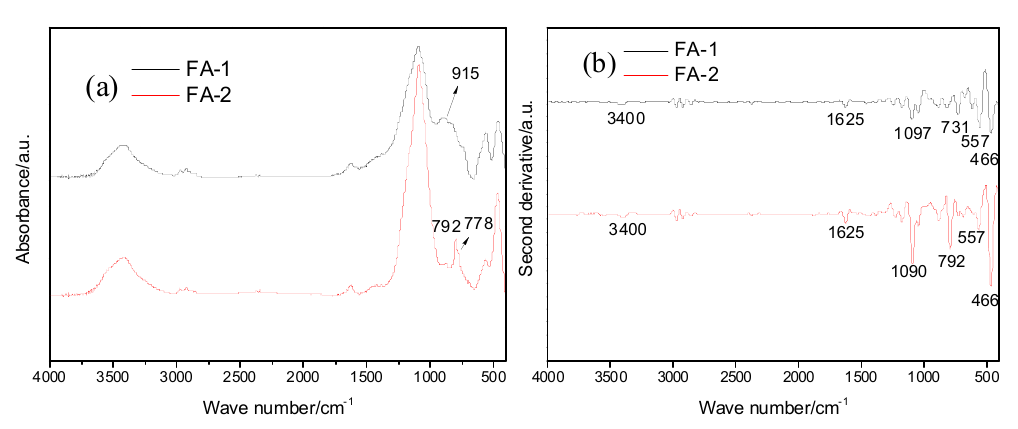
Figure 6. Original ( a ) and second derivative ( b ) Fourier transform infrared (FTIR). spectra for FA-1 and FA-2.